Question: Briefly state, in one sentence, what is plotted here.
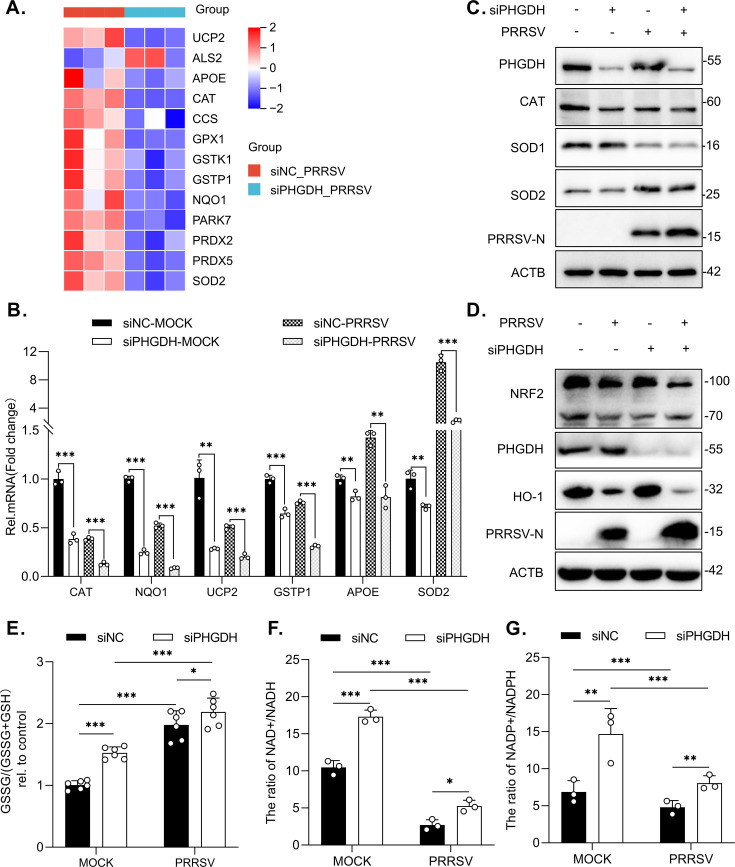
Answer: PHGDH depletion downregulates antioxidant programs and reduces reducing equivalents during PRRSV infection. ( A ) Heatmap of representative antioxidant/redox-related genes from RNA-seq comparing PRRSV-infected siNC and siPHGDH groups. ( B ) RT-qPCR validation of selected antioxidant genes (e.g., CAT, NQO1, UCP2, GSTP1, APOE, and SOD2) in mock- or PRRSV-infected cells transfected with siNC or siPHGDH. ( C ) Immunoblot analysis of the expression of PHGDH and antioxidant proteins (CAT, SOD1, and SOD2) in siNC- or siPHGDH-transfected cells with or without PRRSV infection. ( D ) Immunoblot analysis of the expression of Nrf2 and HO-1 in the indicated groups. ( E ) Cellular glutathione redox state expressed as GSSG/(GSSG + GSH). ( F ) NAD+/NADH ratio. ( G ) NADP+/NADPH ratio. Data are mean ± SD of three independent experiments; each dot represents one independent replicate ( n ≥ 3). Statistical significance was determined using multiple t -tests (for panel B) and the two-tailed Student’s t -test (for panels E–G), * P < 0.05; ** P < 0.01; and *** P < 0.001.